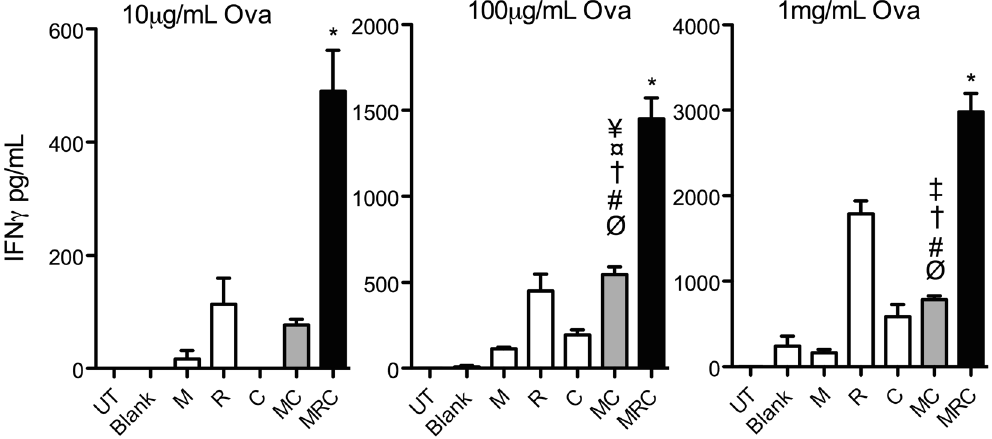
Figure 4. MC and MRC combinations augment antigen cross presentation. BMDCs in medium alone (UT) or exposed to blank PLP (Blank), 10 ng mL − of PLP-MPLA (M), 1 μ g mL − of PLP-R837 (R), or 100 ng mL − of PLP- CpG (C), individually or in combinations of M + C or M + R + C in the presence of soluble Ovalbumin were co- cultured with OTI CD8 T cells at 1:4 ratio for 72 h. Cell free supernatants were harvested and assayed for IFN γ by ELISA. Data are represented as mean ± SEM of 4 or 5 replicates. Statistical analysis was performed by 1 way Anova followed by Tukey’s multiple comparison tests. The following symbols indicate significant differences (p < 0.05) with different groups: * (All); # (UT); ¤ (Blank); † (M); ‡ (R); ¥ (C); $ (MC); Ø